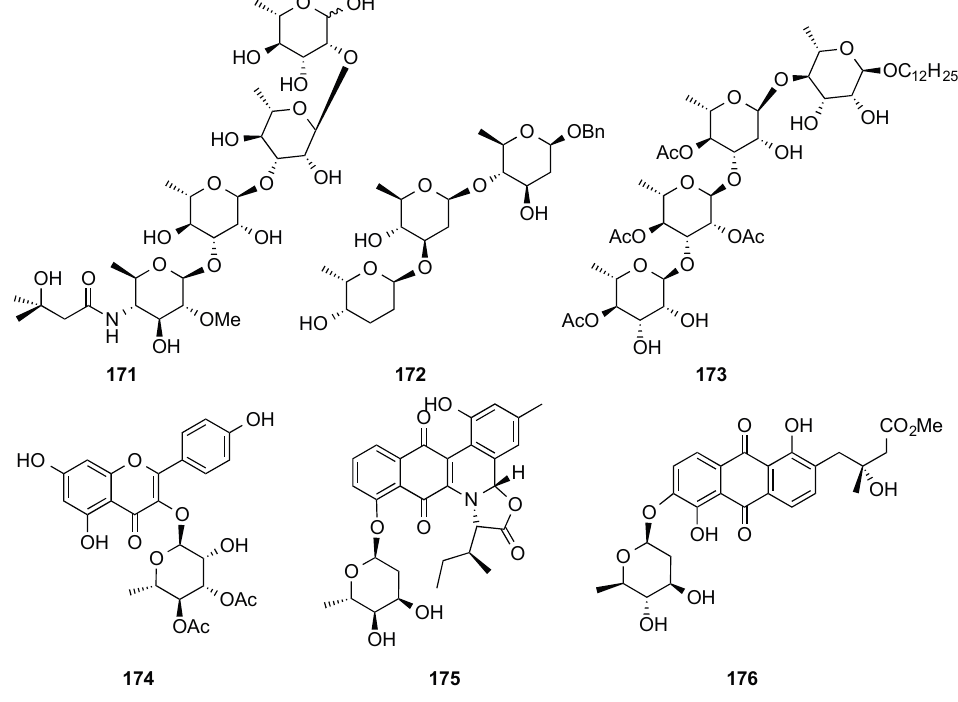
Figure 4. Natural products synthesized by O’Doherty’s